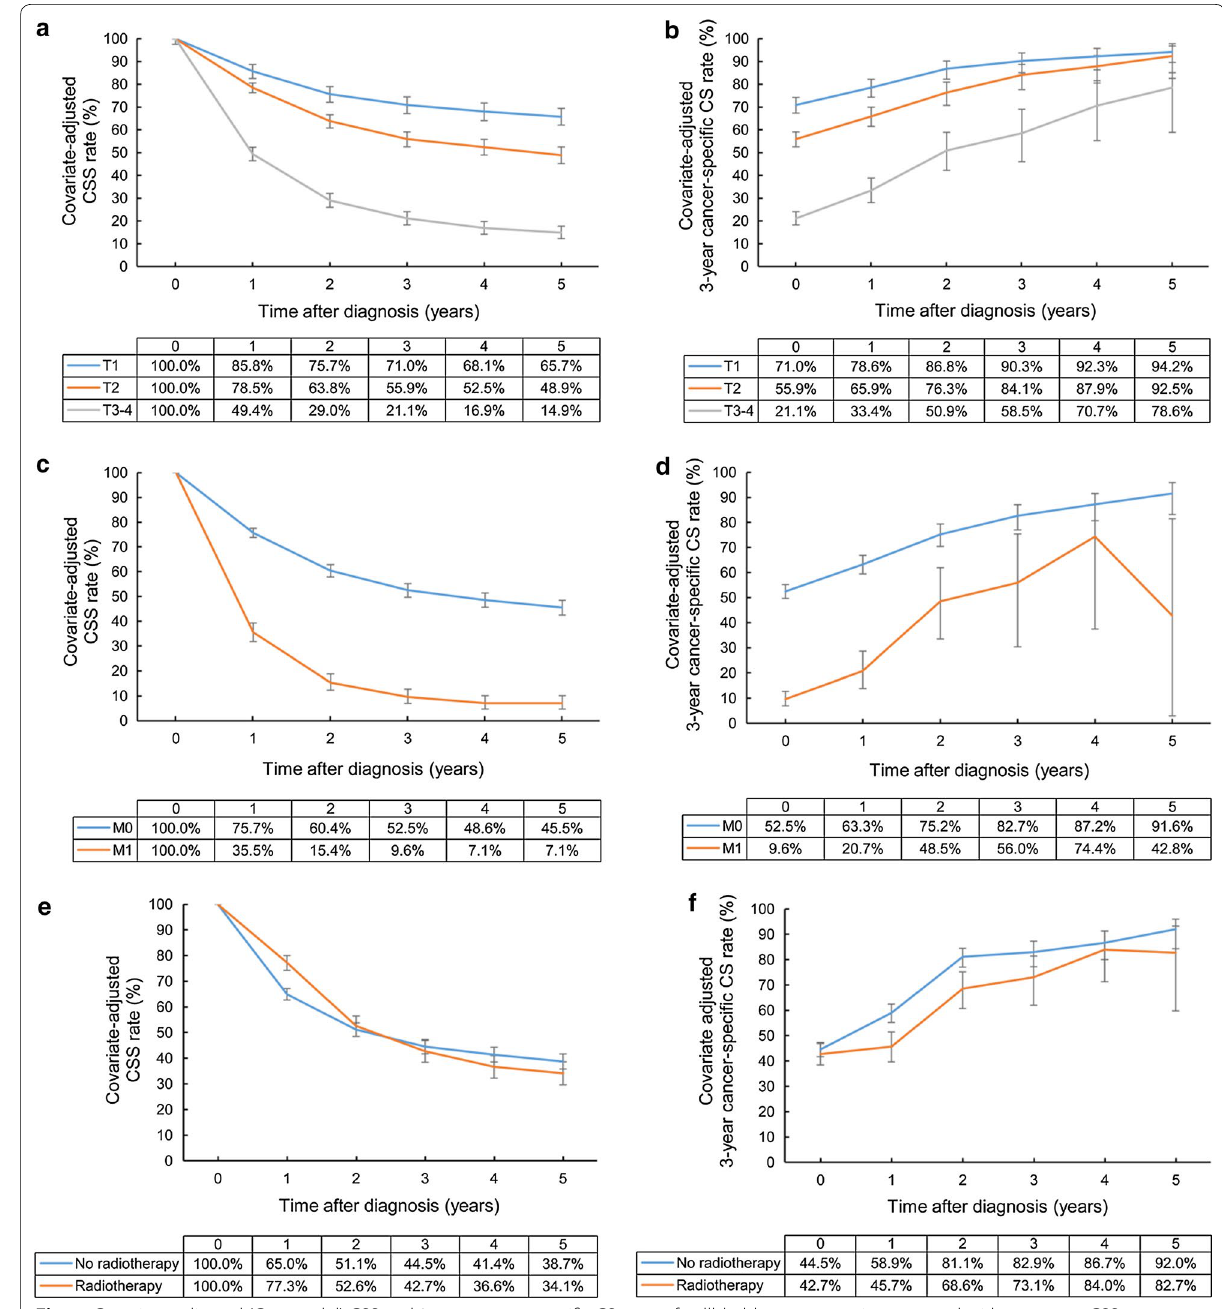
Fig. 4 Covariate‑adjusted (Cox model) CSS and 3‑year cancer‑specific CS rates of gallbladder cancer patients treated with surgery: a CSS rates according to T category; b cancer‑specific CS rates according to T category; c CSS rates according to M category; d cancer‑specific CS rates accord‑ ing to M category; e rates CSS according to radiotherapy; f cancer‑specific CS rates according to radiotherapy. Error bars indicate 95% CIs. CSS cancer‑specific survival, CS conditional